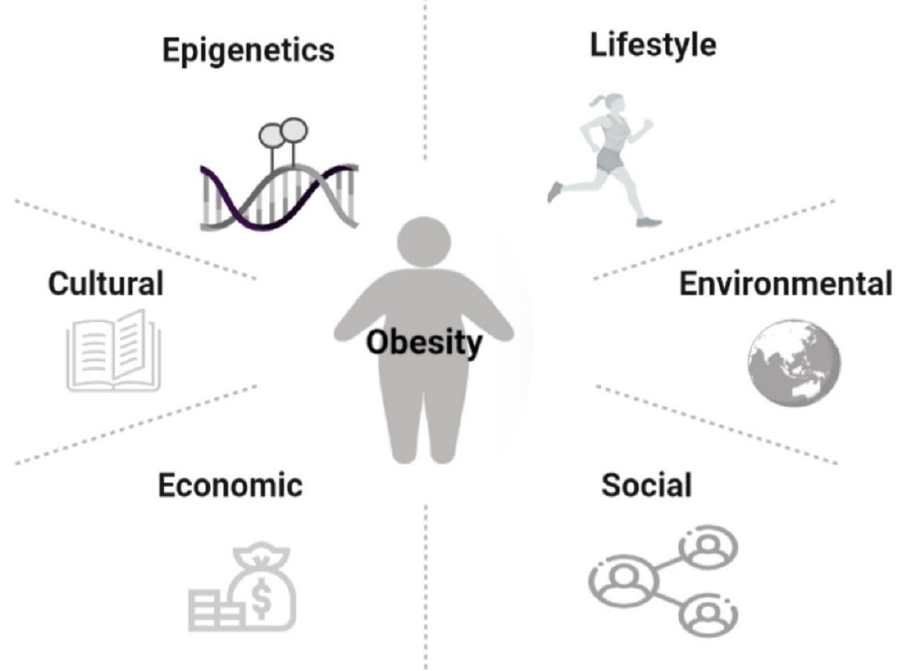
Figure 1. Risk factors of